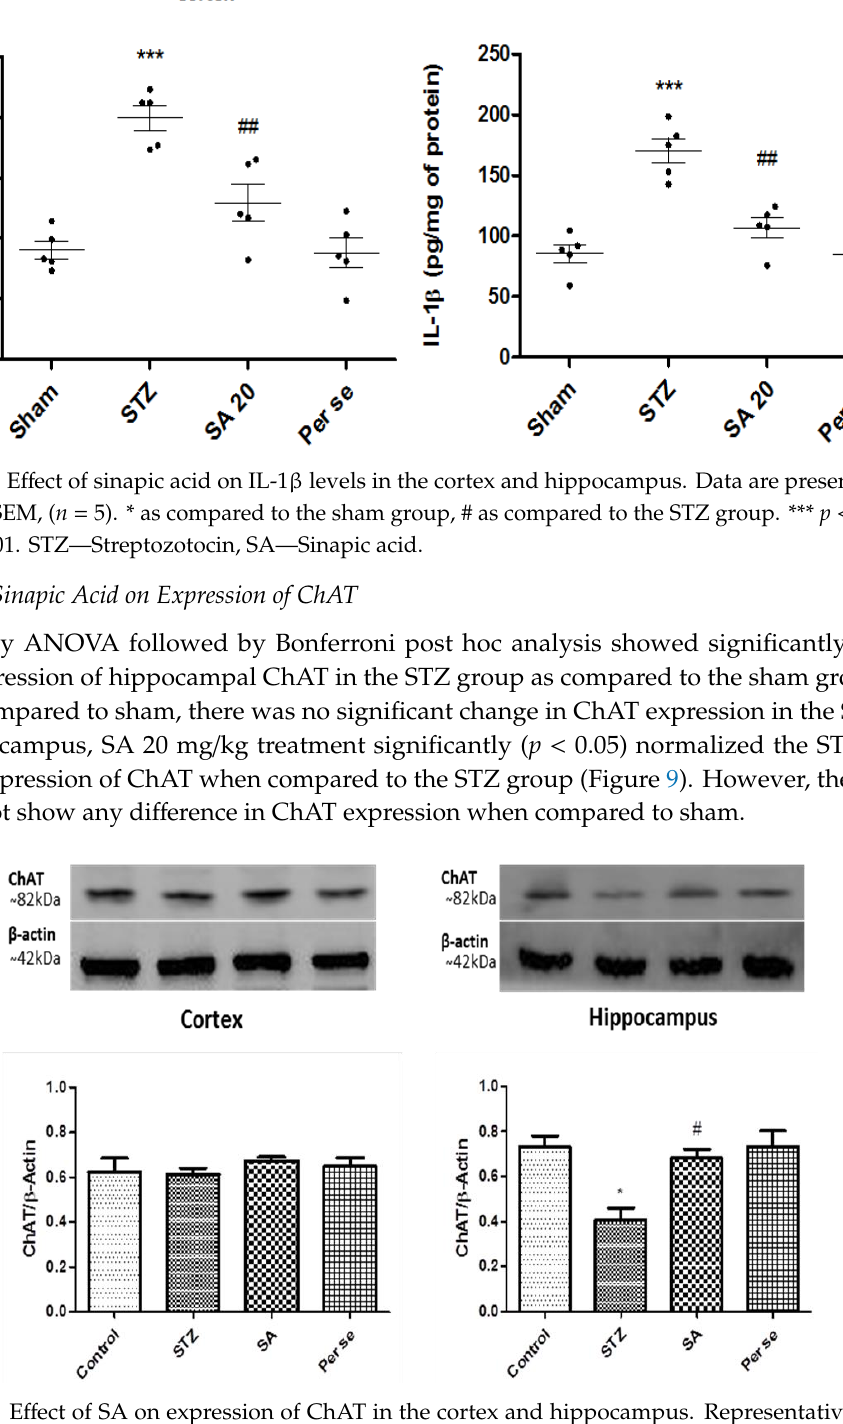
Figure 9. Effect of SA on expression of ChAT in the cortex and hippocampus. Representative blots showing expression of ChAT in the cortex and hippocampus. Bar diagrams show change in ChAT expression when normalized against β -actin. Data are presented as mean ± SEM, ( n = 4). * as compared to the sham group, # as compared to the STZ group. * p < 0.05, # p < 0.05. STZ—Streptozotocin, SA—Sinapic